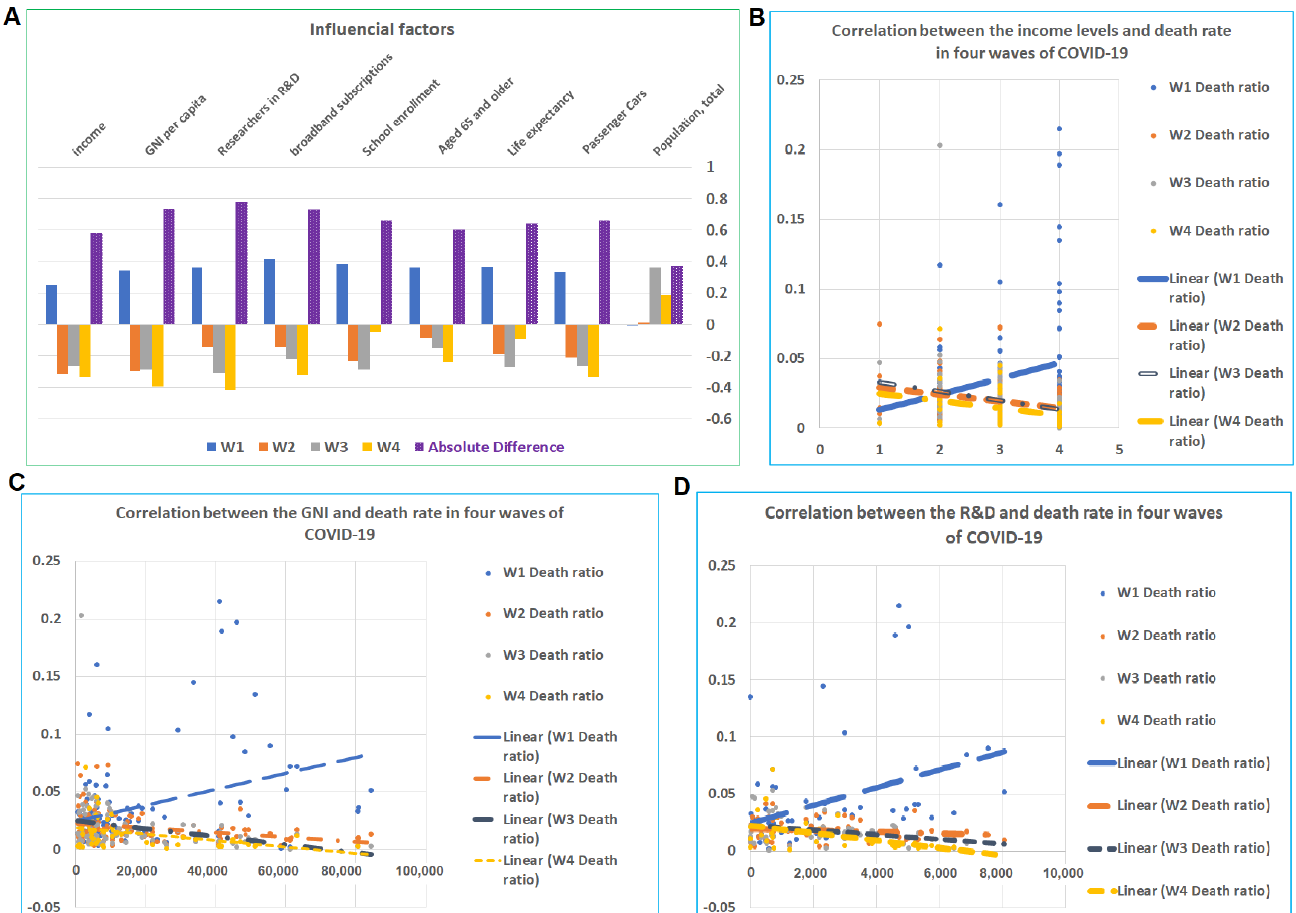
Figure 2. Influential factors on the mortality of COVID-19 during four waves of pandemics. ( A ) Total of nine factors showed r values of more than 3 in at least one wave. The correlations between these nine factors and mortality in wave 1 are in an opposite direction when comparing these correlations with that of waves 2, 3, and 4. ( B – D ) The correlations between the mortality in the four waves and income levels (2B), GNI (2C), and R&D (2D). In each case, wave 1 showed positive correlations, while the other waves showed none or negative correlations.